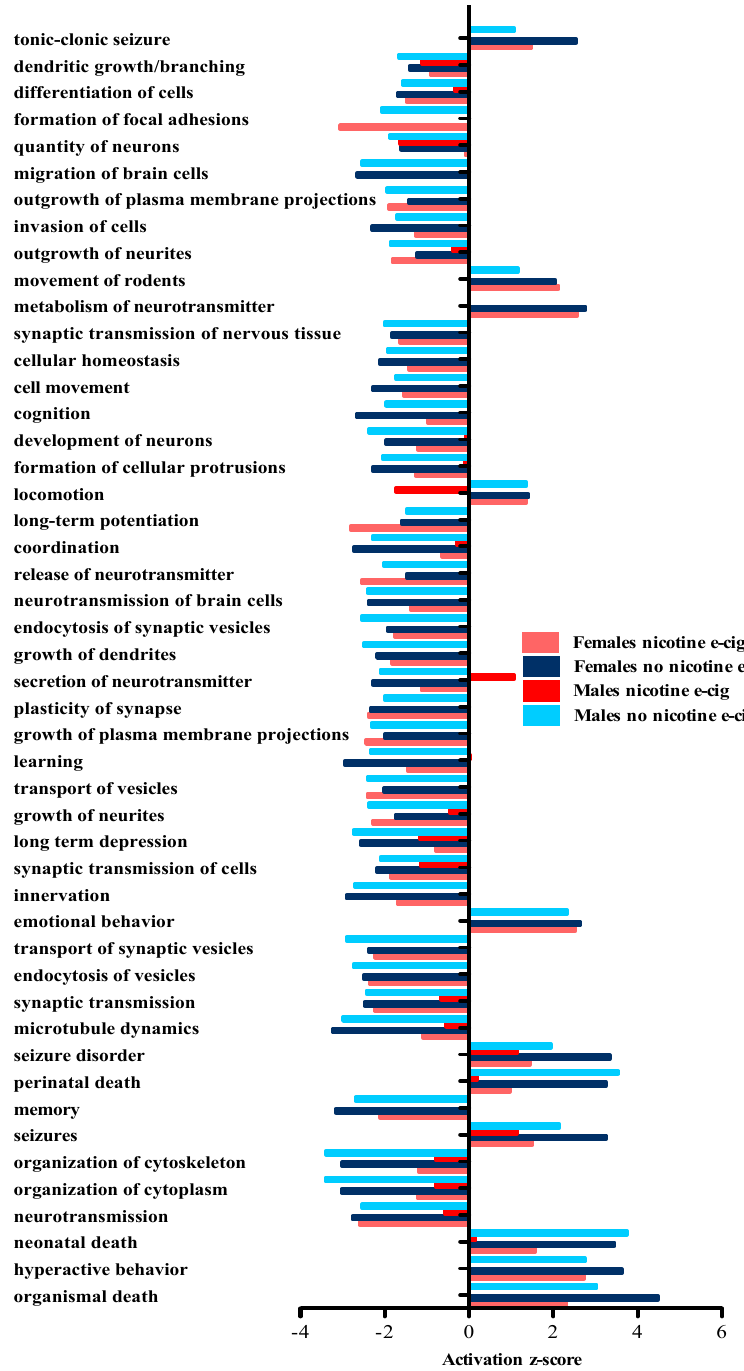
Figure 4. Top 50 disease and biological functions predicted to be altered using IPA comparison analysis. Data obtained from RNA-Seq were filtered to only include those results reaching a p < 0.01 significance level; these RNA-Seq data were then imported into IPA for comparison analysis. A positive activation z-score reflects induction of the indicated disease/biological function, while a negative z-score reflects inhibition of the indicated disease/biological function. Z-scores of +/ − 2.0 were considered significant.